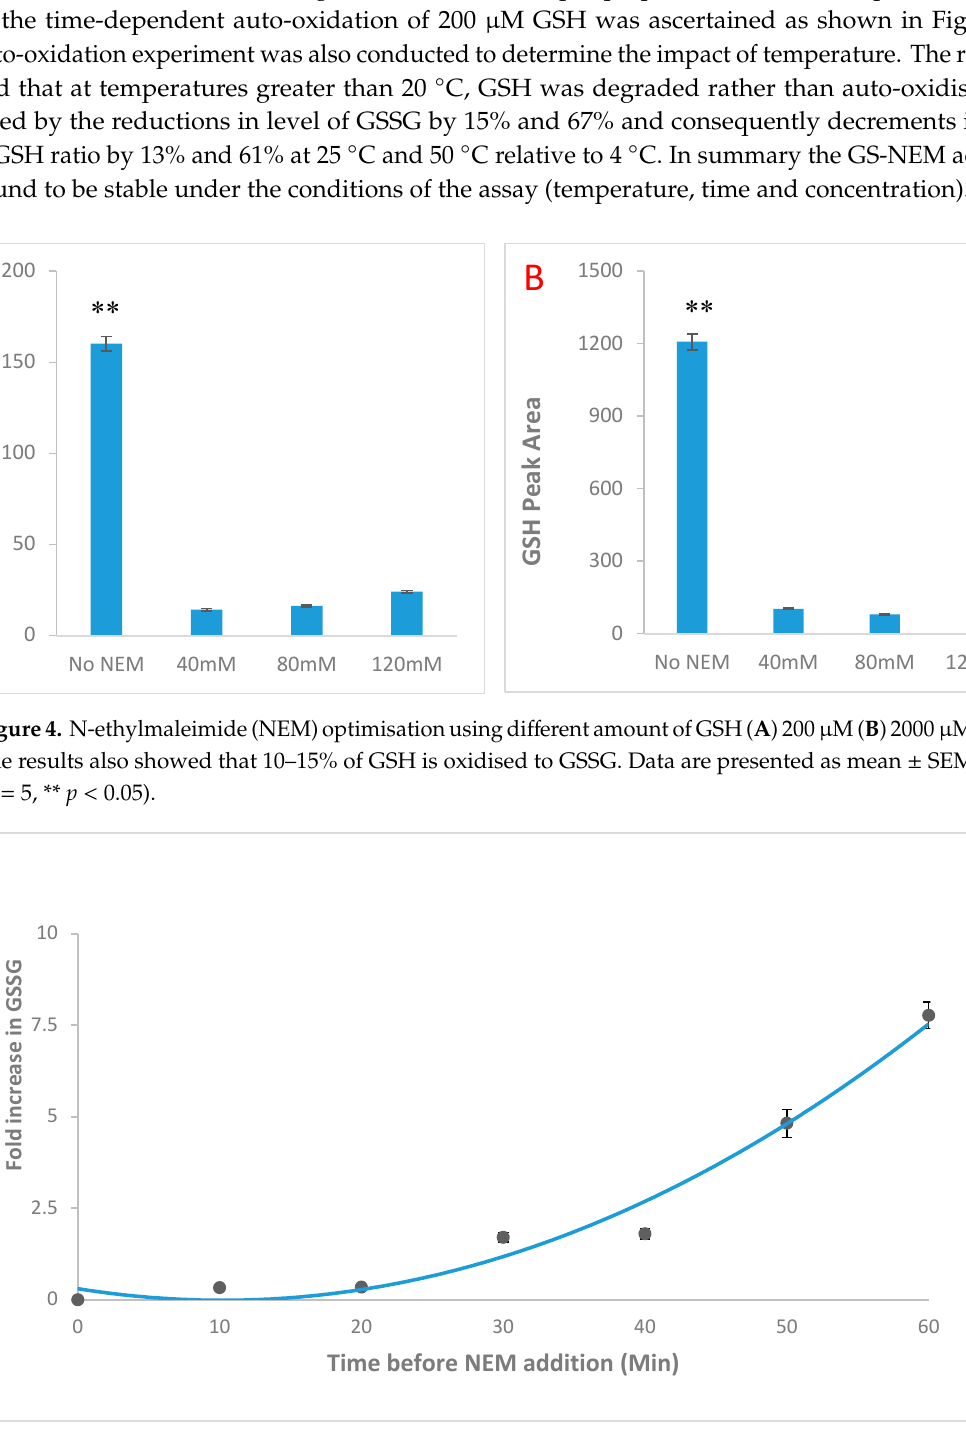
Figure 3. ( A ) Optimal incubation time required of 4 mM reduced glutathione (GSH) with 5% O- pthaldialdehyde (OPA) and subsequent degradation. ( B ) 200µM GSH run at different assay temperatures. Data are presented as mean ± standard error of mean (SEM) ( n = 5, * p < 0.05).